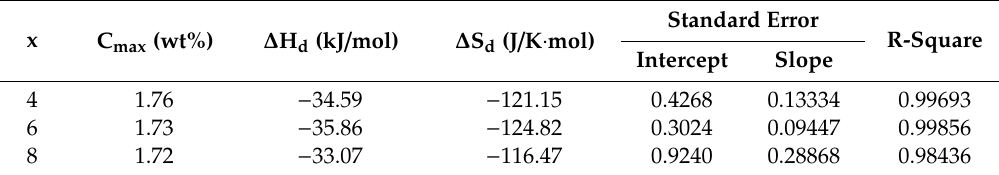
Table 3. Hydrogen storage characteristics linear fitting parameters of TiFe 0.86 Mn 0.07 Co 0.07 + x% Mm (x = 4,6,8) alloys.